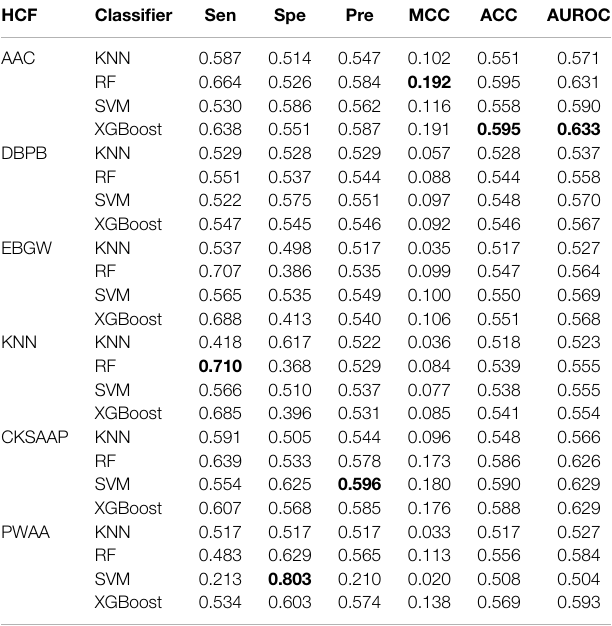
Bold values means the highest values of that column in the tables.